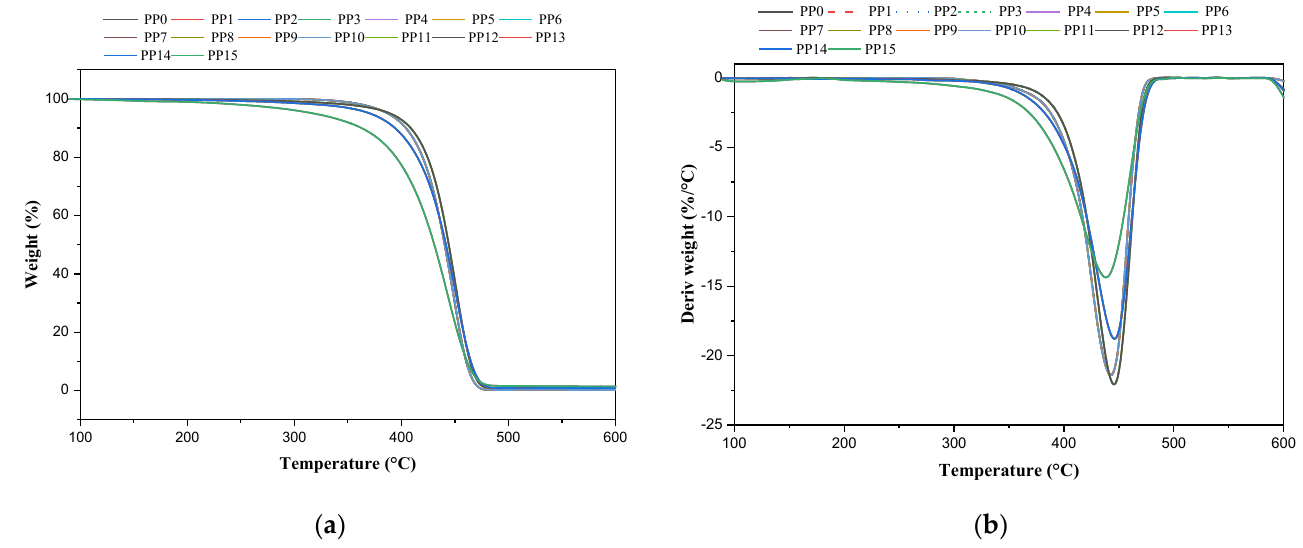
Figure 1. PP samples with methyl acetylene and acetylene; ( a ) TGA; ( b ) DTG.